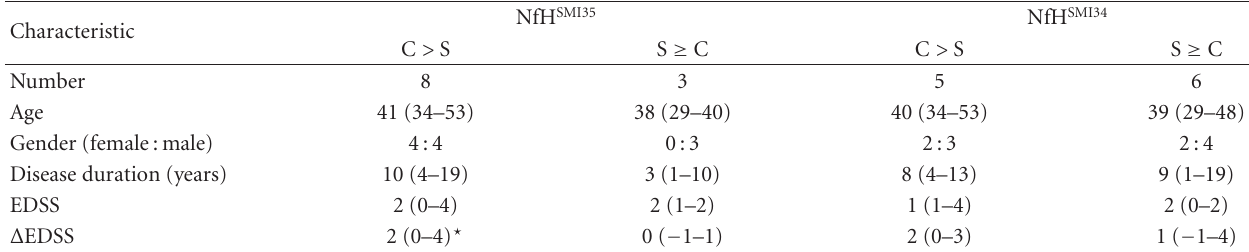
Table 5: Relapsing remitting MS. The patients were classified according to the relationship of CSF and blood NfH levels. If the concentration was higher in the CSF compared to the blood this was indicated by “C > S” and “S ≥ C” otherwise. The data is presented for each of the two NfH phosphoforms quantified (NfH SMI34 and NfH SMI35 ). (cid:2) P < . 05 .